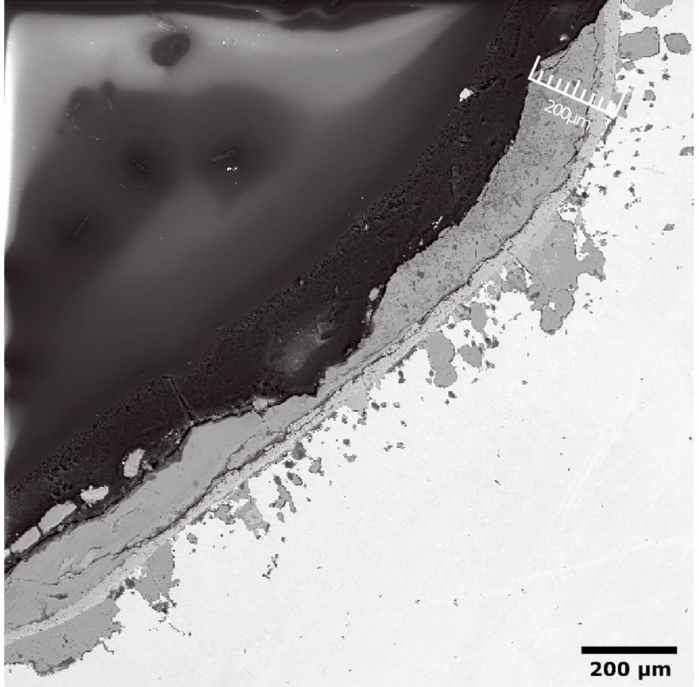
Figure 13. SEM micrograph obtained for Find 1 where the crust can be